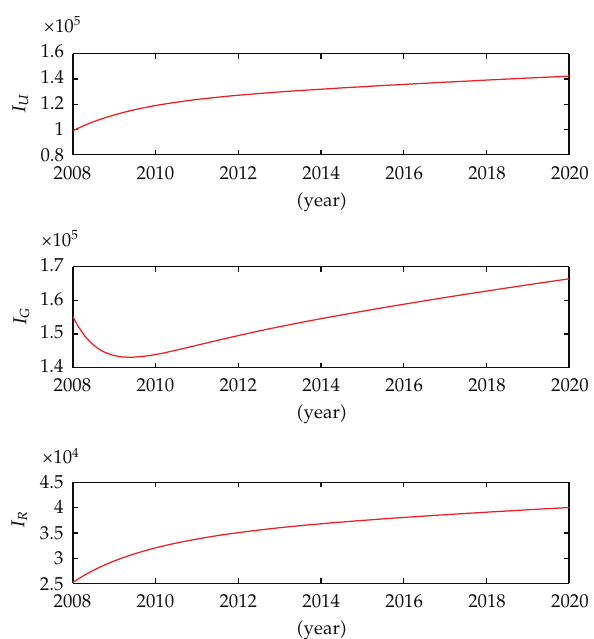
Figure 3: Simulation of system (cid:2) 2.1 (cid:3) in Guangdong province, China. Disease persistence in the population. Using the parameters in Table 1, we obtain R 0 (cid:6) 3 . 5846 > 1.